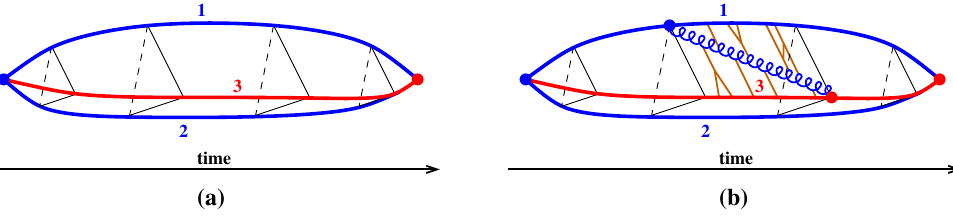
Figure 10 . (a) A redrawing of the time-ordered g → gg hard splitting diagram of figure 3b, depicted here as a 3-dimensional lozenge with triangular cross-section. In the large- N c limit, additions to this diagram representing interactions must be drawable on the surface of the lozenge. The black triangles are just a visual aid, representing cross-sections of the lozenge at instants in time. (b) An example of a soft correction (curly gluon line), along with an example of medium correlations represented by the brown lines. Both 2-point and higher-point correlations are shown by way of example, but the analysis in this paper only assumes that the correlation length of the medium is small compared to formation times, not that the medium is weakly-coupled. Drawing the soft correction and correlators on the surface of the lozenge is just an abstraction for the sake of discussing the dominant time-ordered diagrammatic contributions in the large- N c limit: there is no implication that the physical path of these lines must follow such a surface in transverse position space b